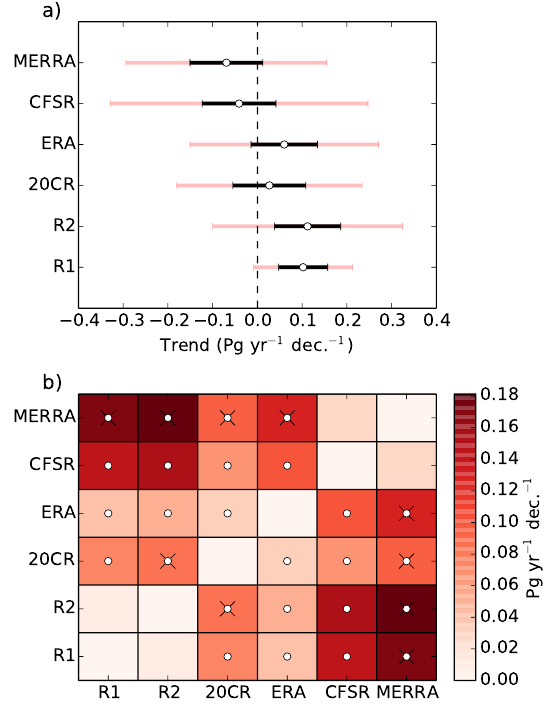
Figure 10. (a) Trends in the net sea–air flux of CO 2 due to wind changes over 1980 to 2010 in the six runs forced by reanalysis winds with 95% confidence intervals in black and adjusted 95% confidence intervals in red; (b) trends of the difference time series in CO 2 flux between all pairwise combinations of the reanalysis- forced runs are given by the shading. A black “x” indicates that the trends are significantly different at the 5% level, based on an adjusted p value and a white circle indicates that the trends are sig- nificantly different at the 5% level, based on an unadjusted p